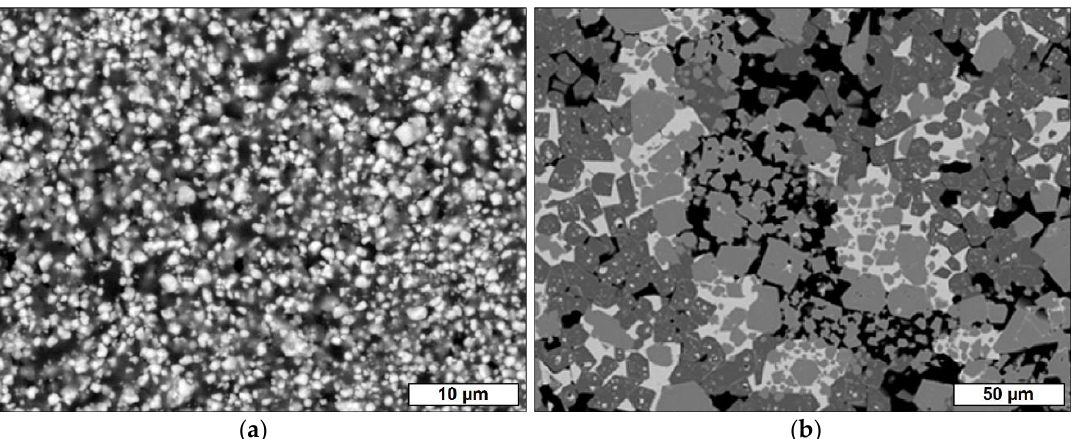
Figure 1 . Scanning electron microscopy (SEM) micrographs of selected Pb(Zr,Ti)O 3 (PZT)-polymer composites with a filler content of 40 vol.% PZT ( a ) after the crosslinking of the silsesquioxane resin at 200 °C and ( b ) after heat treatment processing at 1250 °C.